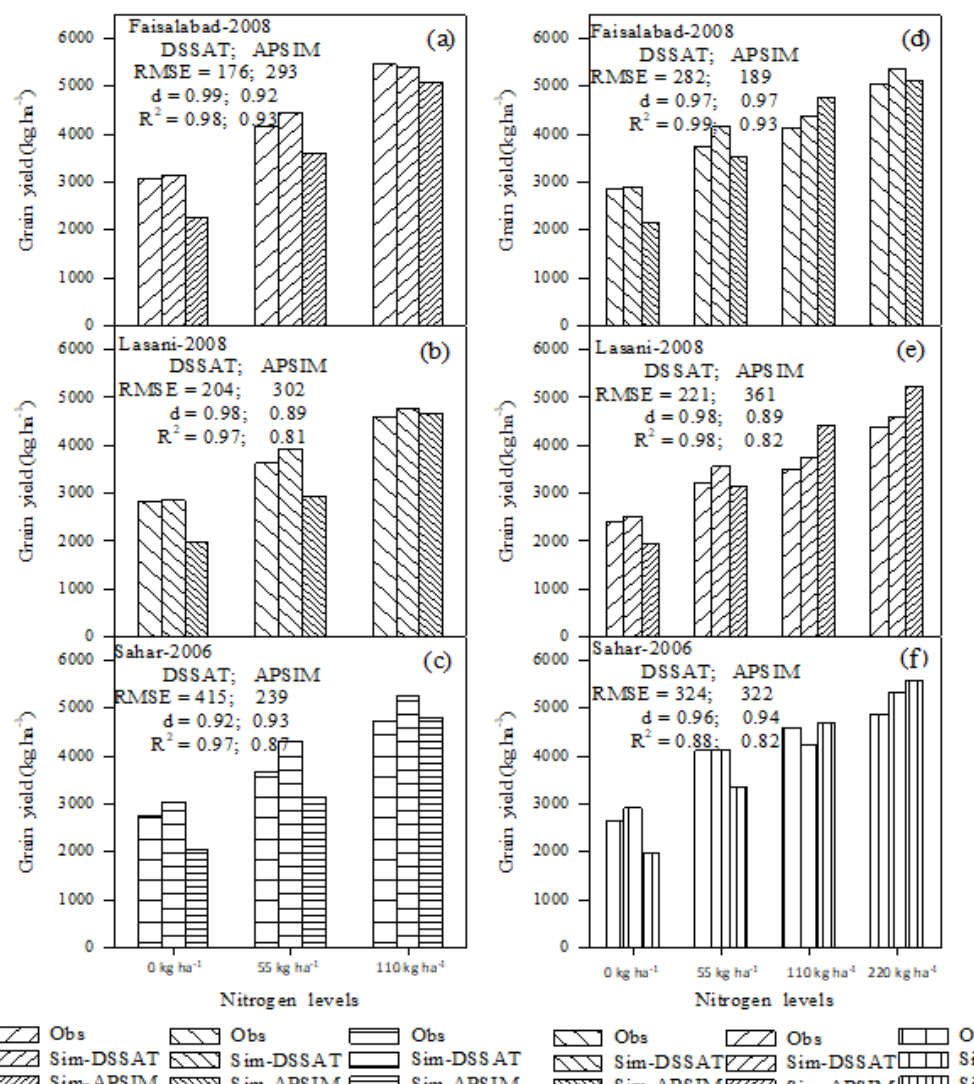
Figure 7. Intercomparison of simulated and observed grain yield (kg ha −1 ) at different nitrogen levels for wheat cultivars during years 2008 – 2009 ( a – c ) and 2009 – 2010 ( d – f ).